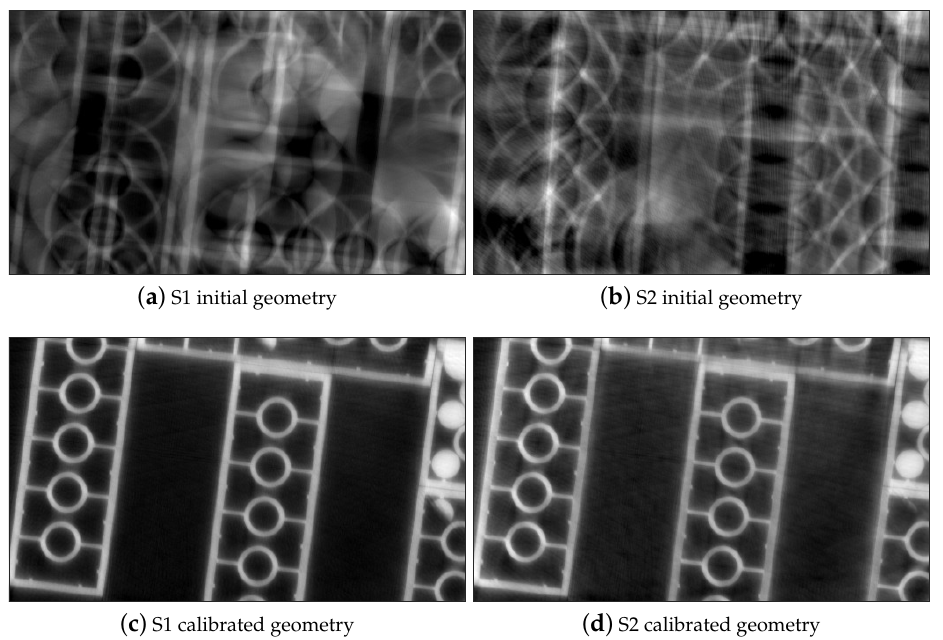
Figure 3. Reconstructions of the test phantom with initial and calibrated stereo geometry parameters for simulated stereo datasets. The LEGO bricks are sharply recovered, misalignment artifacts are elim- inated in the CT slices with calibrated geometry ( c , d ) compared to without applying misalignment correction ( a , b